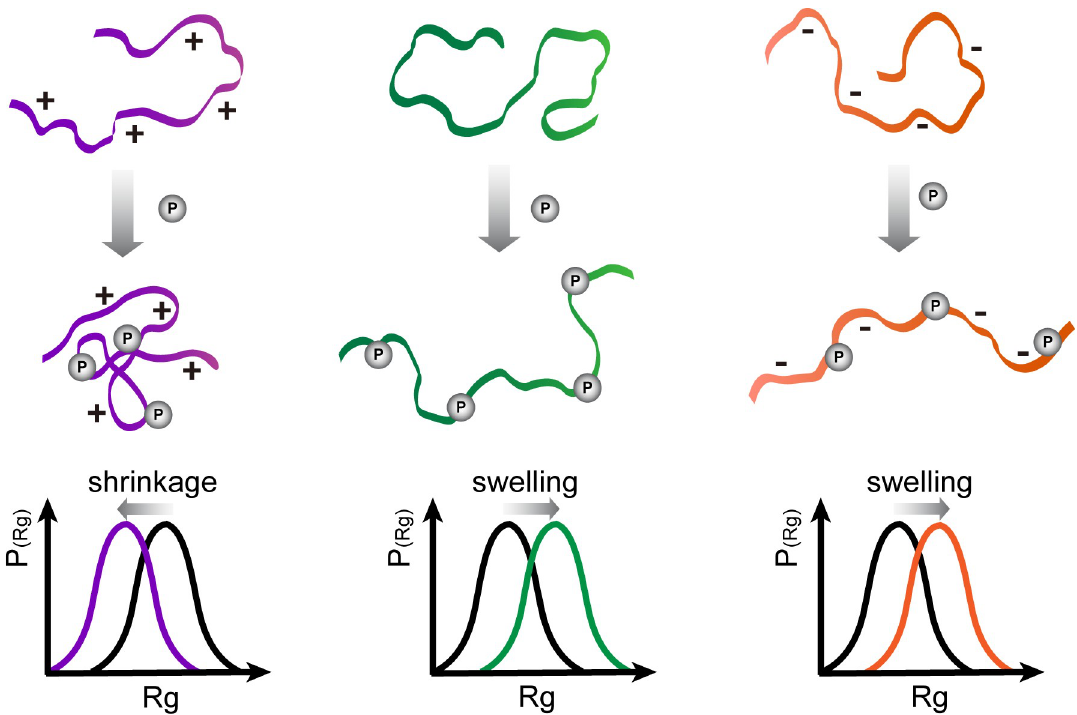
Fig 1. Scheme of the potential effect of phosphorylation on the global conformation of IDPs. Assuming electrostatics to be the major determinant, an overall neutral or negatively charged IDP swells upon phosphorylation, while a positively changed IDP shrinks